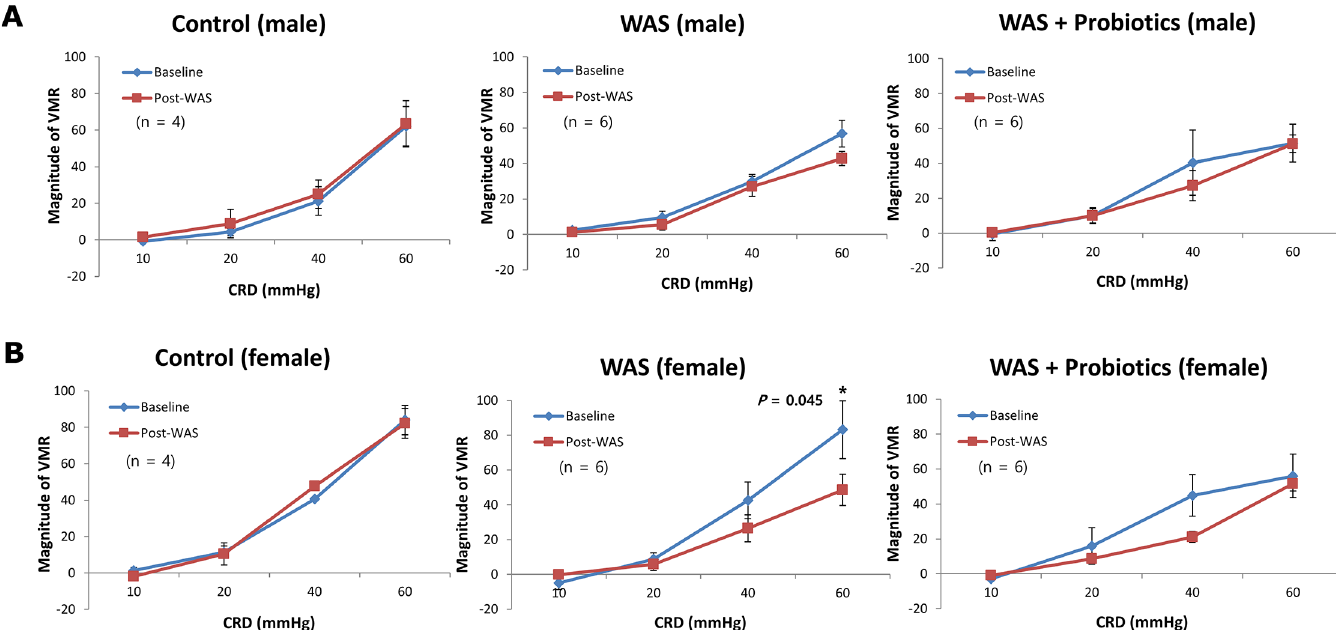
Fig 3. Visceral analgesic responses induced by repeated water avoidance stress(WAS). (A) There was no difference of visceromotor response(VMR) to colorectal distension(CRD) before and after WAS regardlessof treatment of probioticsin male. (B) In contrast VMR to CRD (visceral analgesia) was decreased at 60 mmHg ( P = 0.045) in comparison to baselinein female rats. This WAS-associated visceral analgesia disappearedtreatment of probiotics.